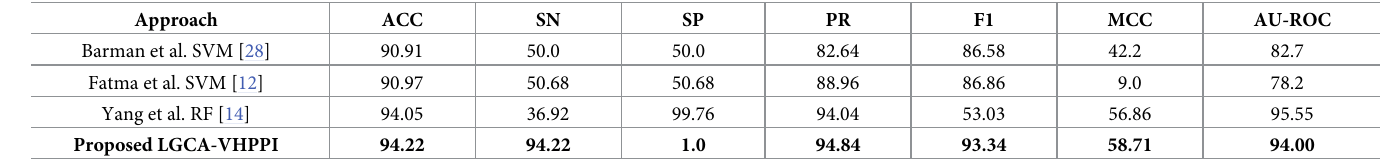
Table 5. Performance comparison of proposed LGCA-VHPPI with existing viral-host PPI predictors over Yang dataset [14] in terms of 7 different evaluation mea- sures. Performance Figures of Barman et al. SVM [28] and Fatma et al. SVM [12] on Yang et al. dataset are computed using their proposed methodologies. Performance figures of Yang et al. RF [14] are taken from Yang et al. work